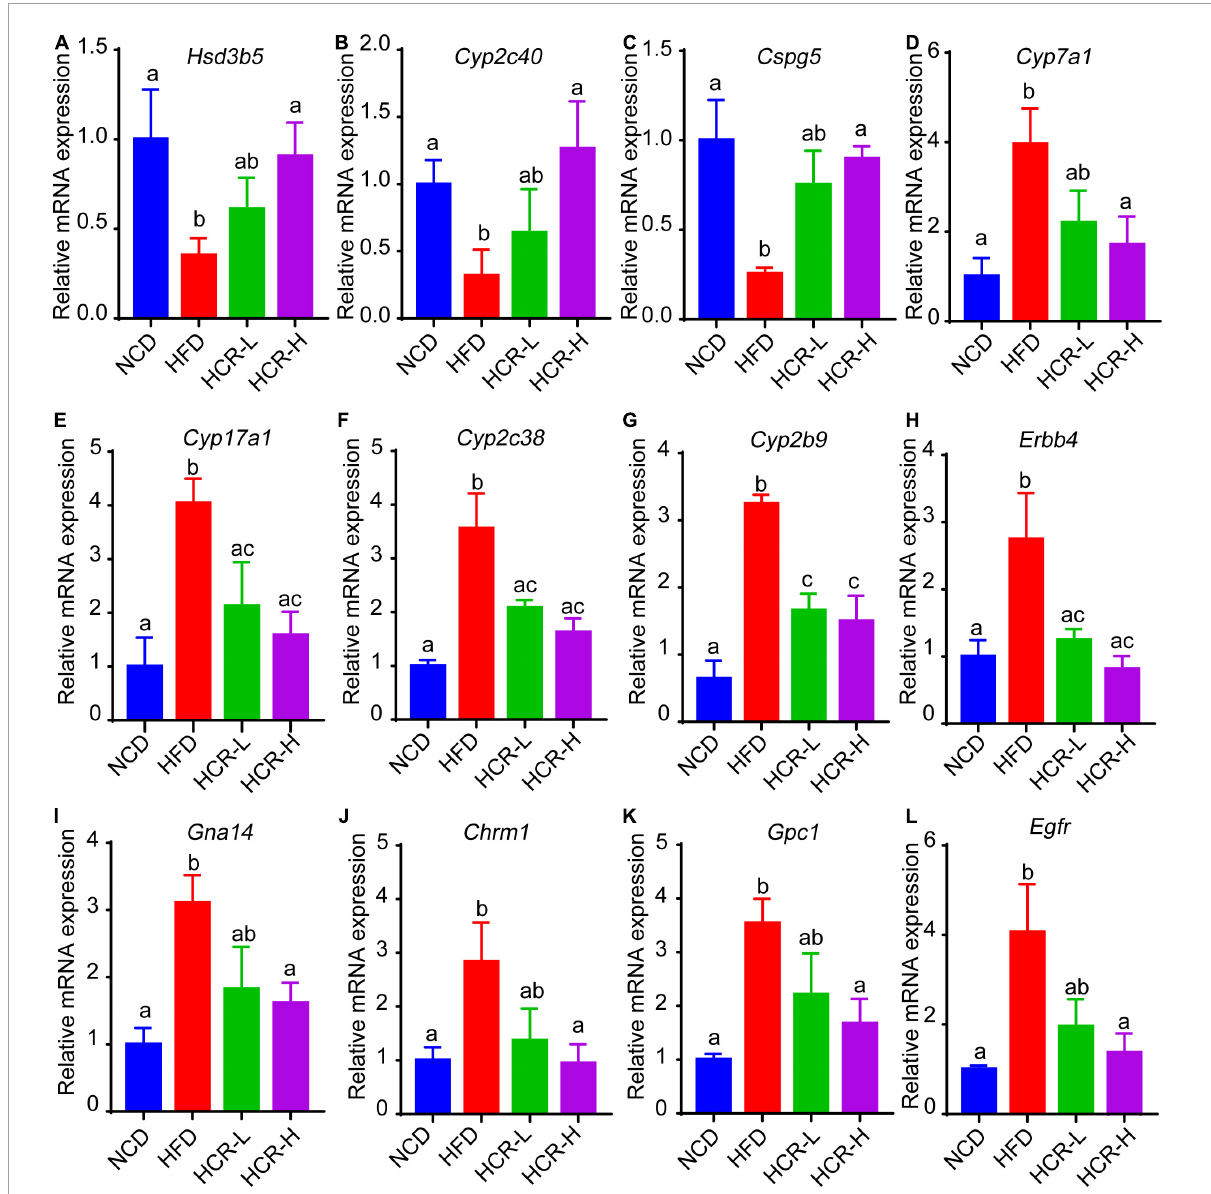
FIGURE8 Relative mRNA expression of hub genes via qPCR analysis. Compared with HFD group, The mRNA expression of Hsd3b5 , Cyp2c40 , Cspg5 in HCR group were increased; by contrast, the mRNA expression of Cyp7a1 , Cpy17a1 , Cyp2c38 , Cyp2b9 , Egfr , Erbb4 , Gna14 , Chrm1 , and Gpc1 in HCR group were